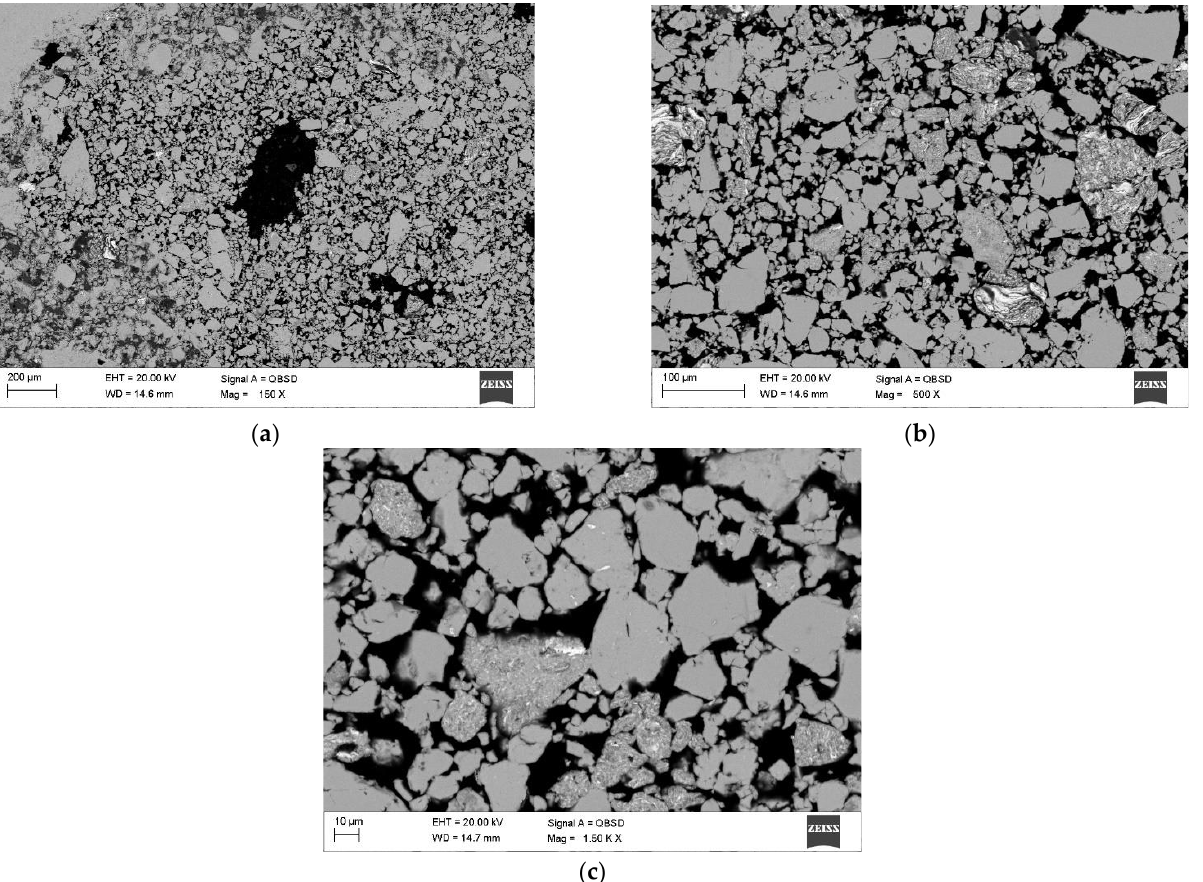
Figure 3. SEM images obtained for Mg 65 Zn 30 Ca 4 Ag 1 alloy after 70 h of milling, with the following magnification: ( a ) 150 × ; ( b ) 500 × ; ( c ) 1500 ×